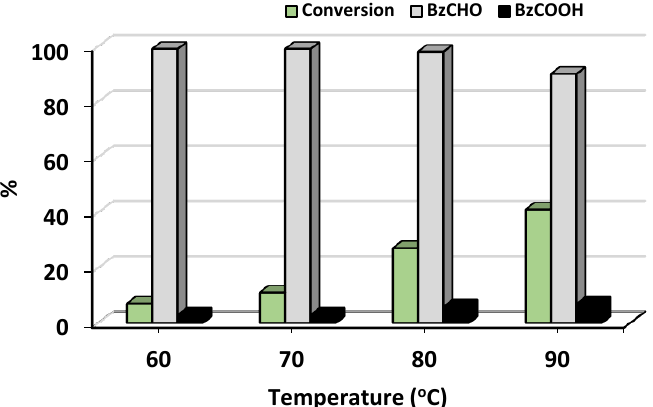
Figure 5. Effect of temperature; Conversion is based on benzyl alcohol; benzyl alcohol (100 mmol); TBHP (0.15 mmol); amount of catalyst (100 mg); O 2 balloon 1 atm; TBHP (0.15 mmol); time (24 h); BzCHO—Benzaldehyde; BzCOOH—Benzoic acid.